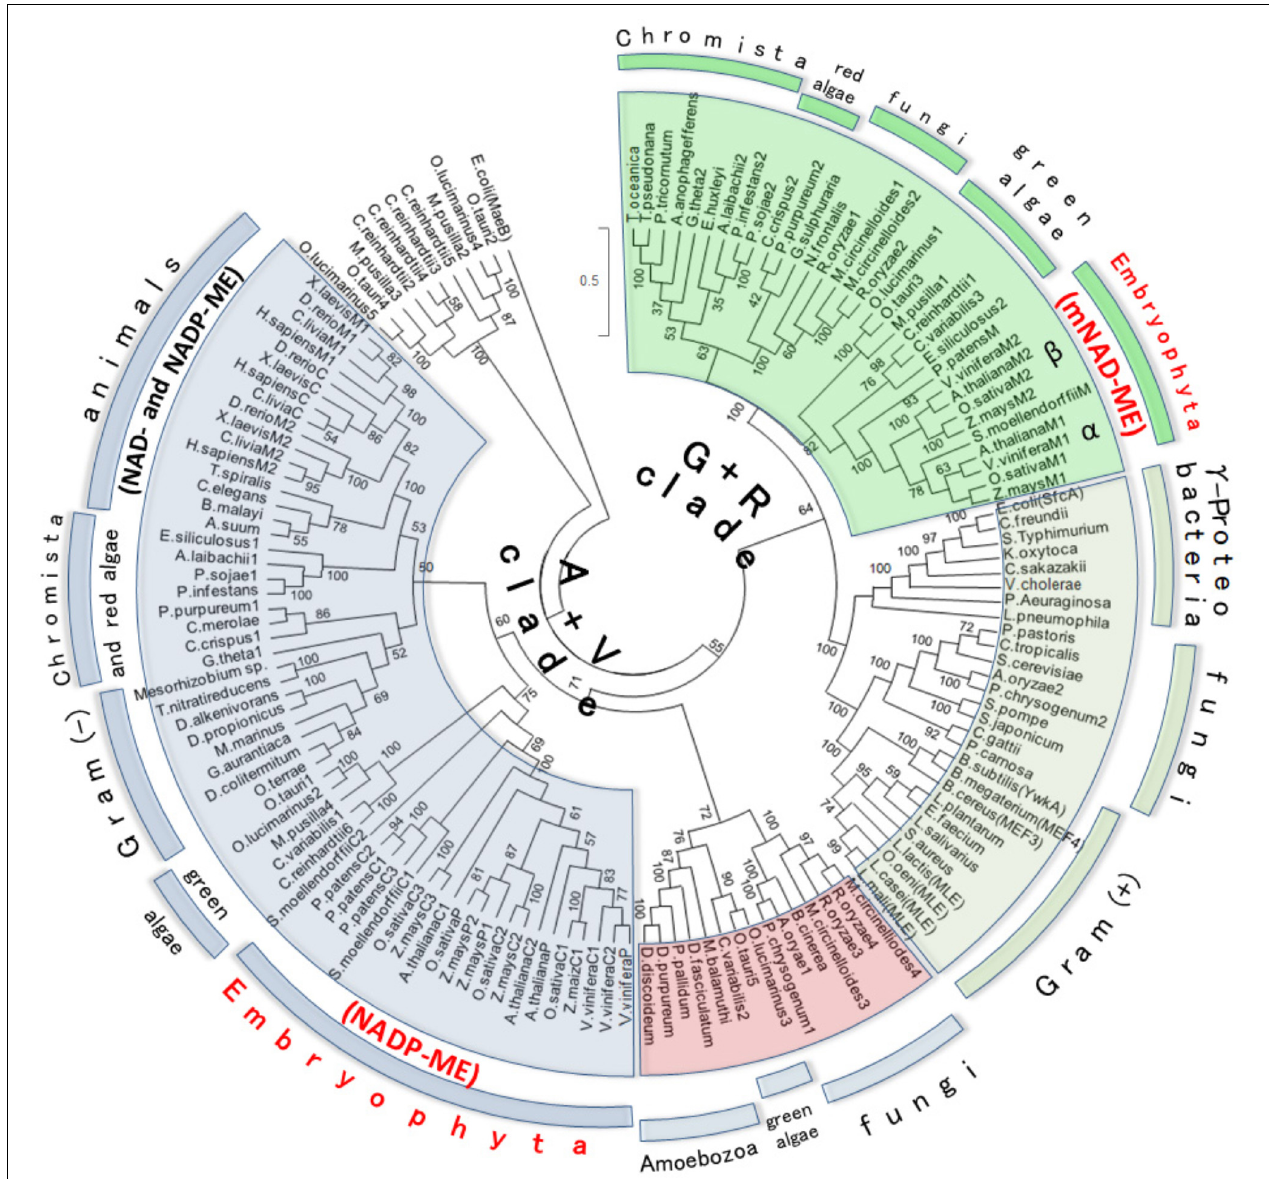
FIGURE 3 | Maximum likelihood tree of Class I-ME protein sequences. Evolutionary history was inferred by using the ML method based on the WAG + G (2.0533) + I (2.6198) evolutionary model. The tree with the highest log likelihood (–73118.4895) is shown. Analysis involved 134 amino acid sequences (see Supplementary Table S1 for list of gene IDs). All positions with less than 95% site coverage were eliminated. The final data set comprised a total of 491 positions. The tree is drawn to scale, with branch distance separating two taxa measured in the number of substitutions per site. Numerals indicate support of branches, which were assessed using 500 boostrap replicates. MaeB sequence from E. coli (a Class II-ME) was included in the analysis as out-group. For animal and plant MEs, M, P, and C indicate mitochondrial, plastidic, and cytosolic isoforms, respectively. The A+V Clade groups Animalia + Viridiplantae MEs, while G+R Clade clusters green + red isoforms. Plant ME family members, which are distributed between A+V and G+R lineages, are highlighted in red letters. α and β indicate the two plant mNAD-ME